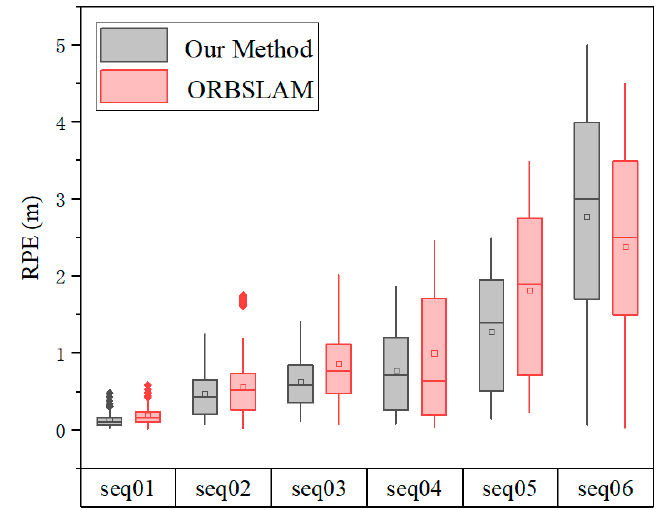
Figure 8. Relative Pose Error for our method and ORB-SLMA2 in 6 sequences.